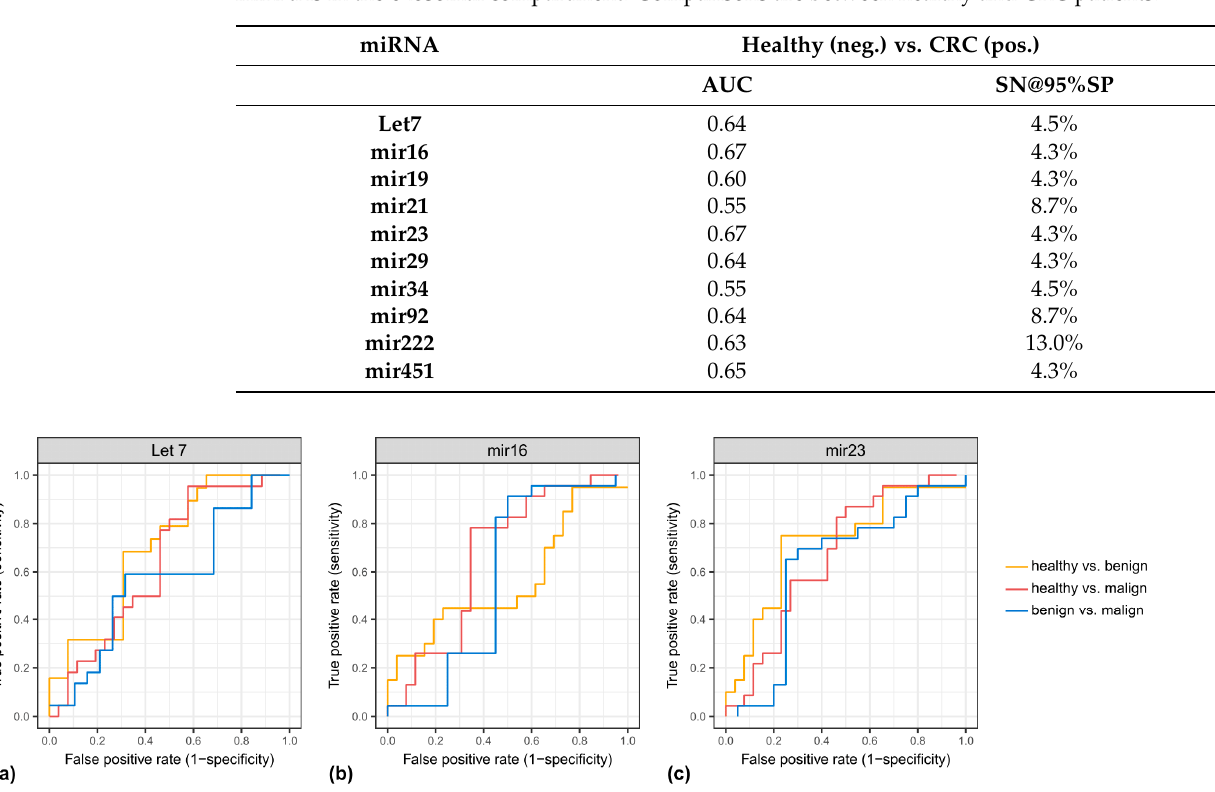
Figure 3. ROC curves of ( a ) Let7, ( b ) mir16 and ( c ) mir23 in the exosomal compartment. X-axis: false positive rate (1-specifity), y-axis: true positive rate (sensitivity).